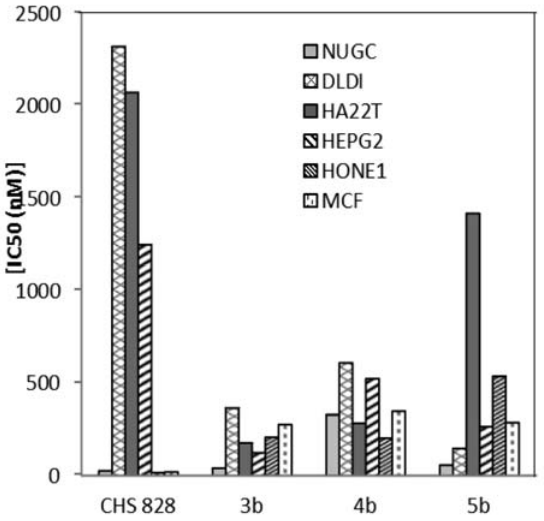
Figure 3 . Cytotoxicity of 3b , 4b , 5b and CHS 828 against NUGC (gastric cancer); DLDI (colon cancer); HA22T (liver cancer); HEPG2 (liver cancer); HONE1 (nasopharyngeal carcinoma); MCF (breast